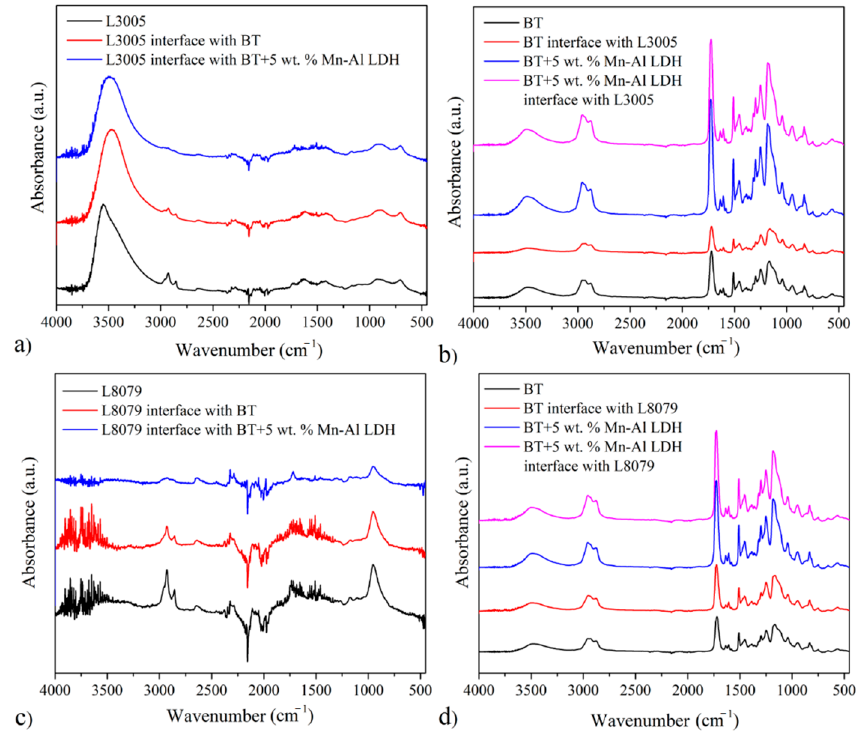
Figure 7. FTIR analysis of ( a ) L3005 and its interfaces, ( b ) BT and BT composite adhesives and their interfaces with L3005, ( c ) L8079 and its interfaces, and ( d ) BT and BT composite adhesives and their interfaces with L8079.